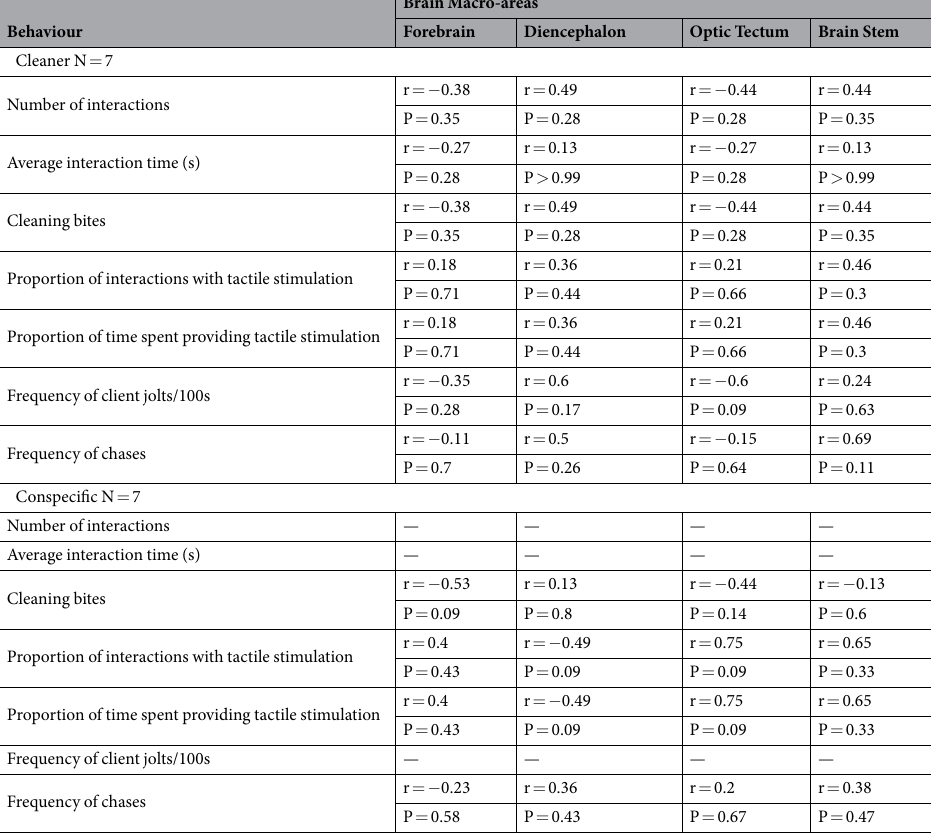
Table 2. Correlations (Spearman correlation coefficients) between each behavioural measure and serotonin levels in different brain macro-areas for the two experimental treatments: client exposed to a cleaner ( Labroides dimidiatus ) or a conspecific ( Naso elegans ). There were no statistically significant